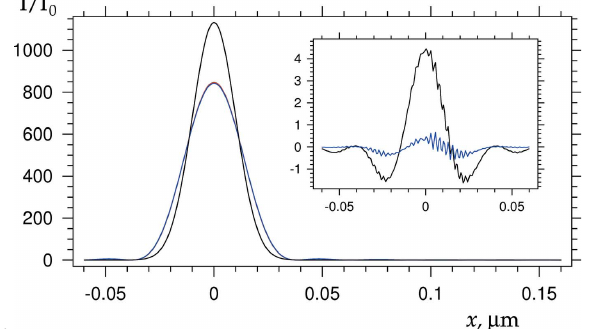
Figure 3 Relative intensity distribution at the focal distance. See details in the